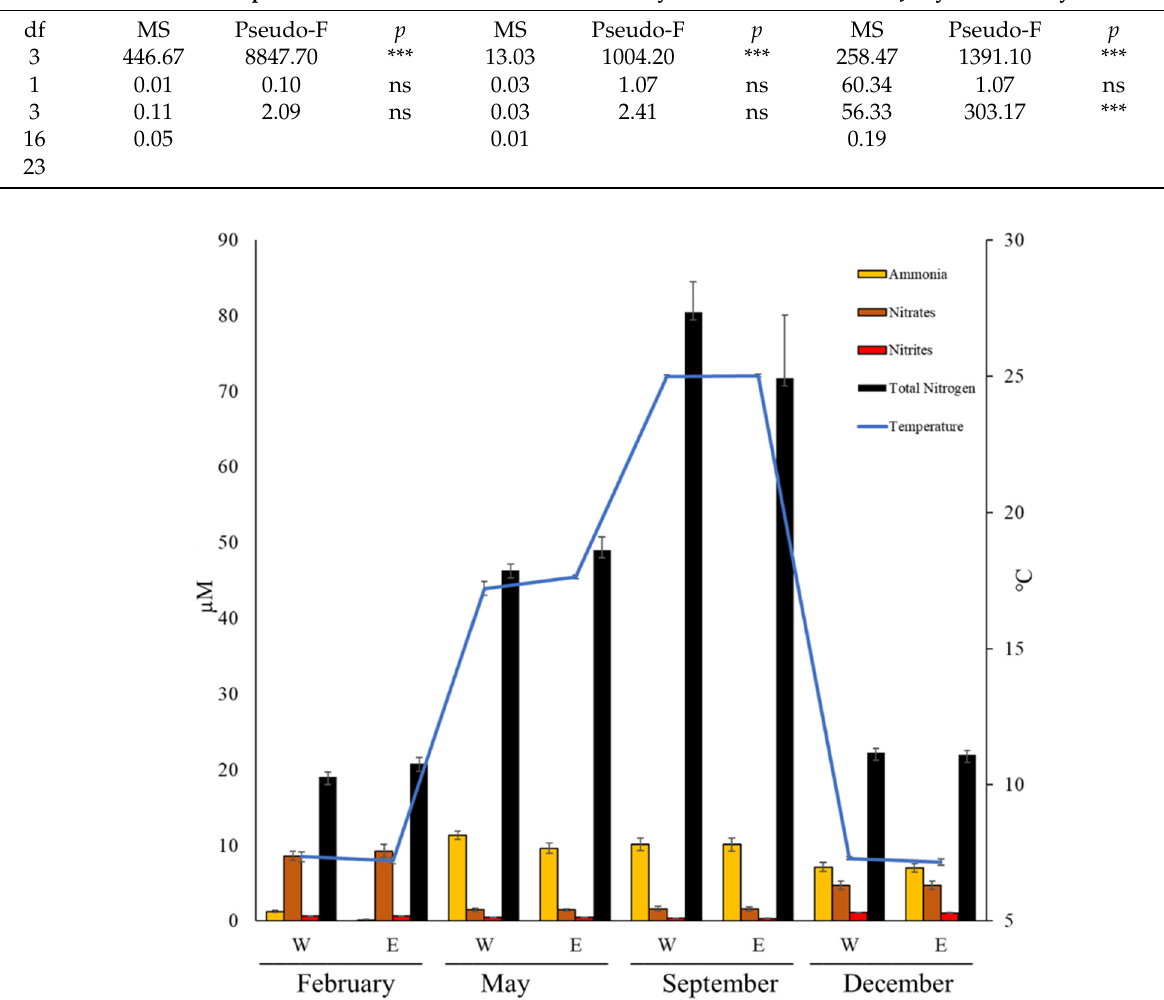
Figure 2. The seawater temperature and nutrient variables (ammonia, nitrites, nitrates, and total nitrogen) characterizing the water columns of the W and E zones during the sampling times.